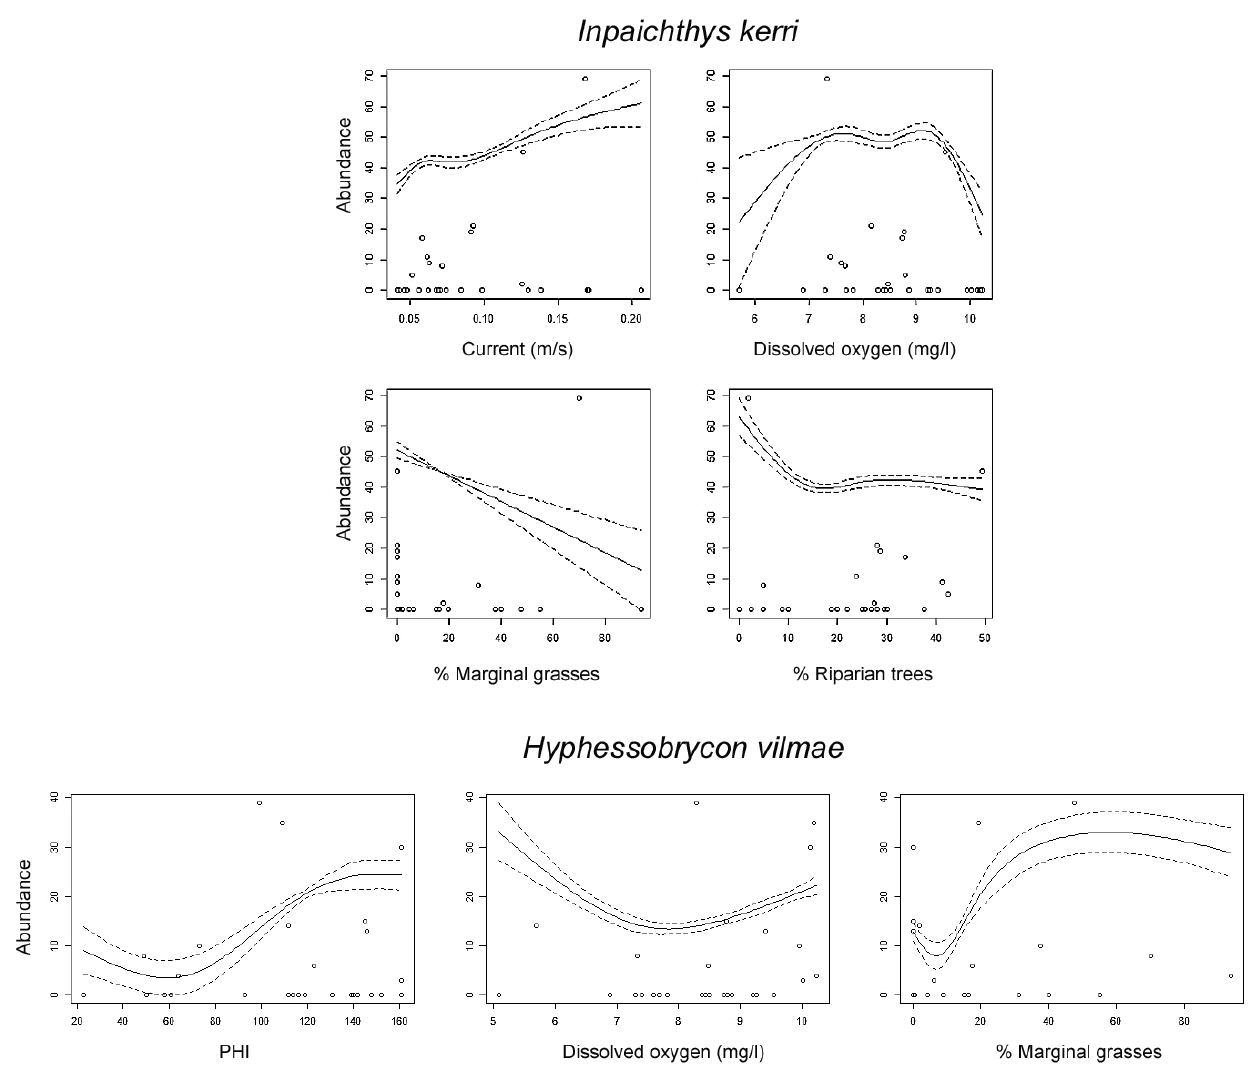
FIGURE 4 | Relationships obtained from generalized additive mixed models (GAMM) among the environmental variables and Inpaichthys kerri ( A ) and Hyhessobrycon vilmae ( B )